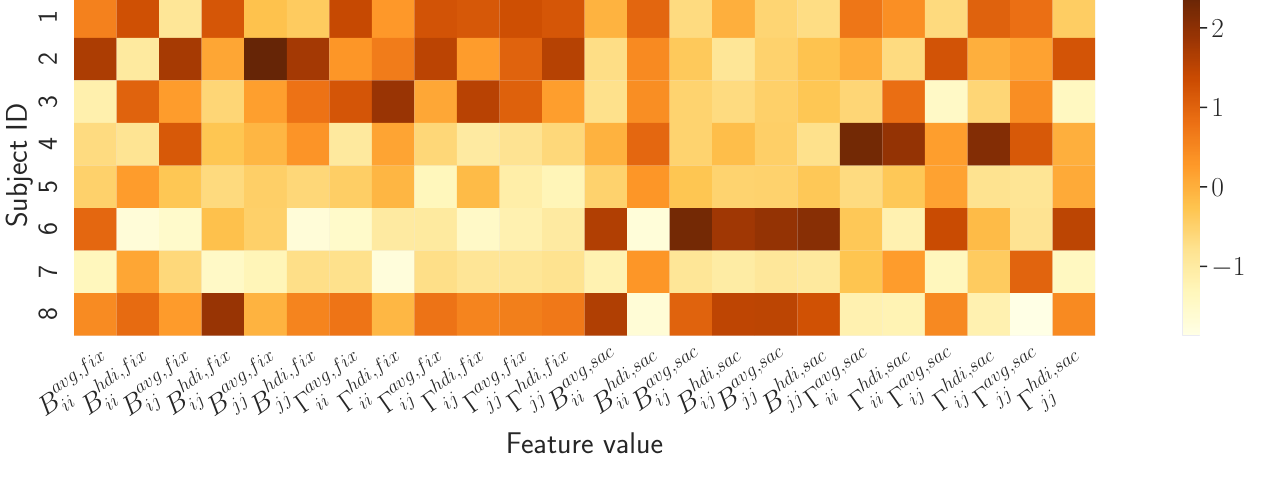
Figure 7. Heatmap contrasting the model-based descriptors of observers’ visual behaviour. Each row of the map renders the summary vector are associated to colours as depicted in the side